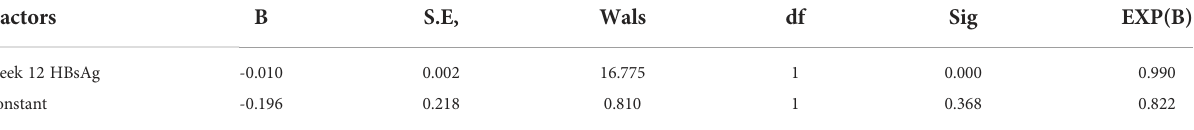
TABLE 7 Predict week 48 HBsAg seroconversion with week 12 indicators.